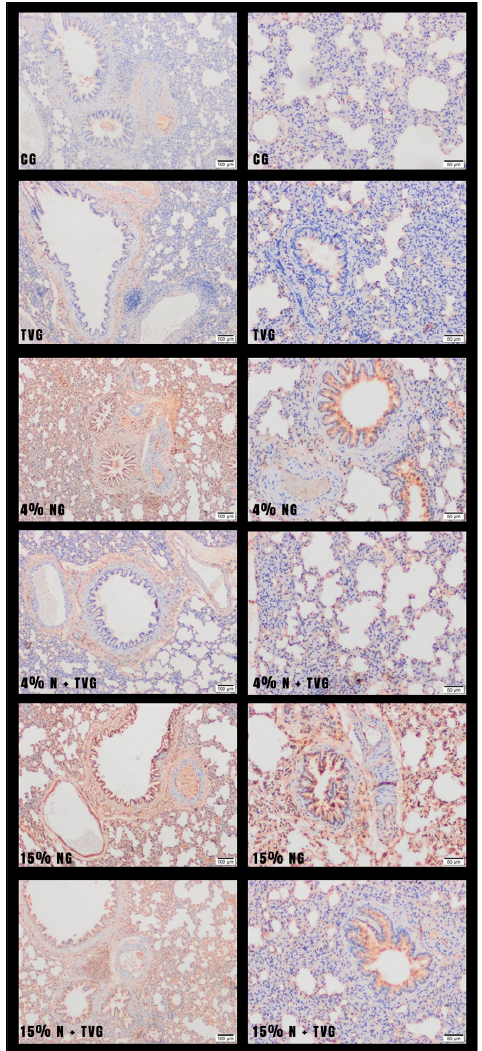
Figure 6. In CG and TVG, mild TNF- α expression was observed in the bronchiolar epithelium. In 4% NG and 15% NG, moderate and intense levels of TNF- α expression were observed in bronchiolar epithelium and macrophages in the alveolar lumen, respectively. 4% N + TVG and 15% N + TVG showed significant decreases in TNF- α expression. In the H-scoring, in which the differences between the groups were evaluated, a sig- nificant expression increase was found in 4% NG and 15% NG, and it was observed that the expression levels were significantly decreased in 4% N + TVG and 15% N + TVG (Fig- ure 7).